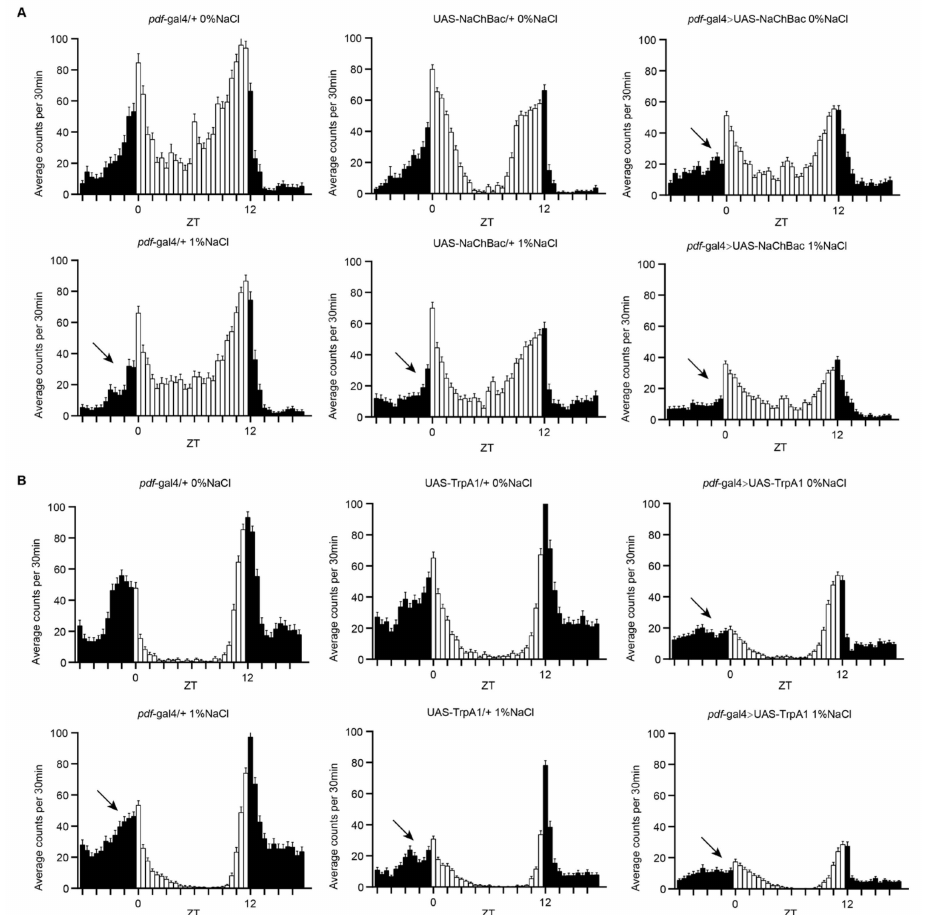
Figure 5. Enhancement of neuronal function in PDF-expressing neurons mimics the HSD that causes impaired morning anticipation in flies. ( A ) Locomotor activity of the indicated strains measured during three days under LD conditions. pdf -Gal4 drives UAS-NaChBac expression and controls ( pdf -Gal4/+ and UAS-NaChBac/+) were fed HSD or normal diet. ( B ) Locomotor activity of the indicated strains measured during three days under LD and 29 ◦ C conditions. pdf -Gal4 drives UAS-TrpA1 expression and controls ( pdf -Gal4/+ and UAS-TrpA1/+) were fed HSD or normal diet. Arrows indicate perturbed morning